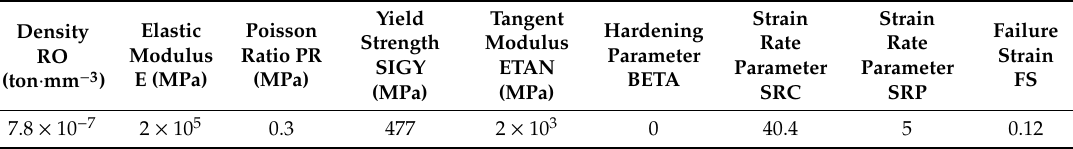
Table 2. The material parameters of steel.